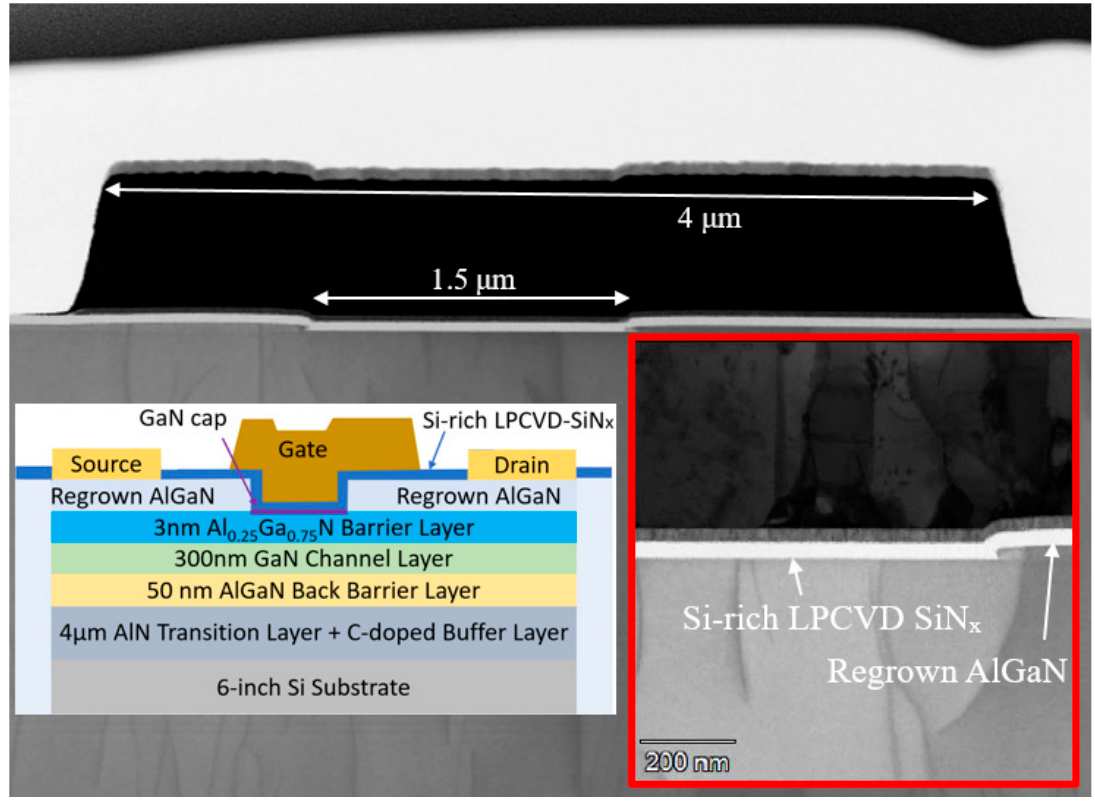
Figure 1. The layer structure and cross-sectional SEM images of Si-rich LPCVD-SiN x MISHEMT with a selective area ohmic regrowth layer.